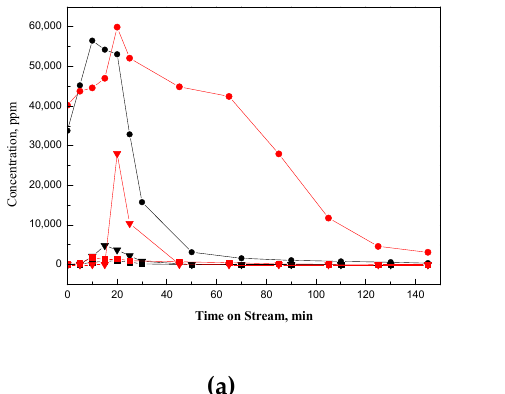
Figure 3. ( a ) CO 2 , CO formed in temperature programmed regeneration of EtOH-laden NaY-SiO 2 : CO 2 formed at high flow rate (black • ), CO 2 formed at low flow rate (red • ), CO formed at high flow rate (black ■ ), CO formed at low flow rate (red ■ ); blue line solid line in the figure is the setting temperature. ( b ) CO 2 , CO formed in temperature programmed regeneration of EtOH-laden Pt/NaY- SiO 2 : CO 2 formed at high flow rate (black • ), CO 2 formed at low flow rate (red • ), CO formed at high flow rate (black ■ ), CO formed at low flow rate (red ■ ).